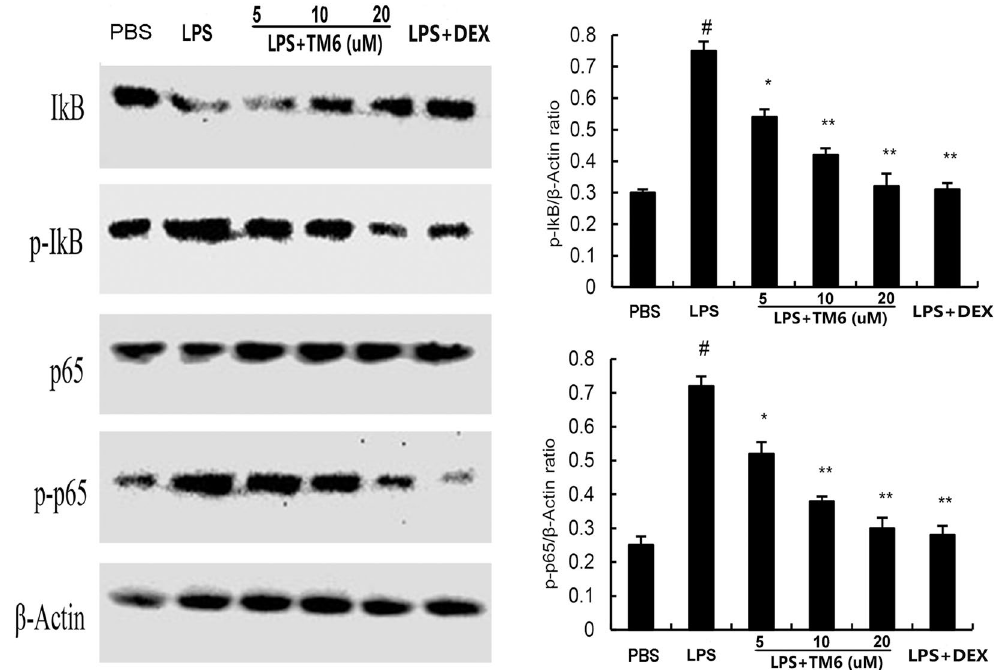
Figure 8. The effect of TM6 on NF- κ B pathway. The effects of TM6 on the expression of the NF- κ B pathway that was induced by LPS. Alveolar macrophages were pretreated with TM6 (5, 10 and 20 µ M) for 1 hour and then treated with LPS for 1 hour. NF- κ B protein samples were analyzed by western blot with specific antibodies. β -actin was used as a control. The values presented are the means ± SEM of three independent experiments, # P < 0.01 is significantly different from the control group; * P < 0.05 and ** P < 0.01 are significantly different from the LPS